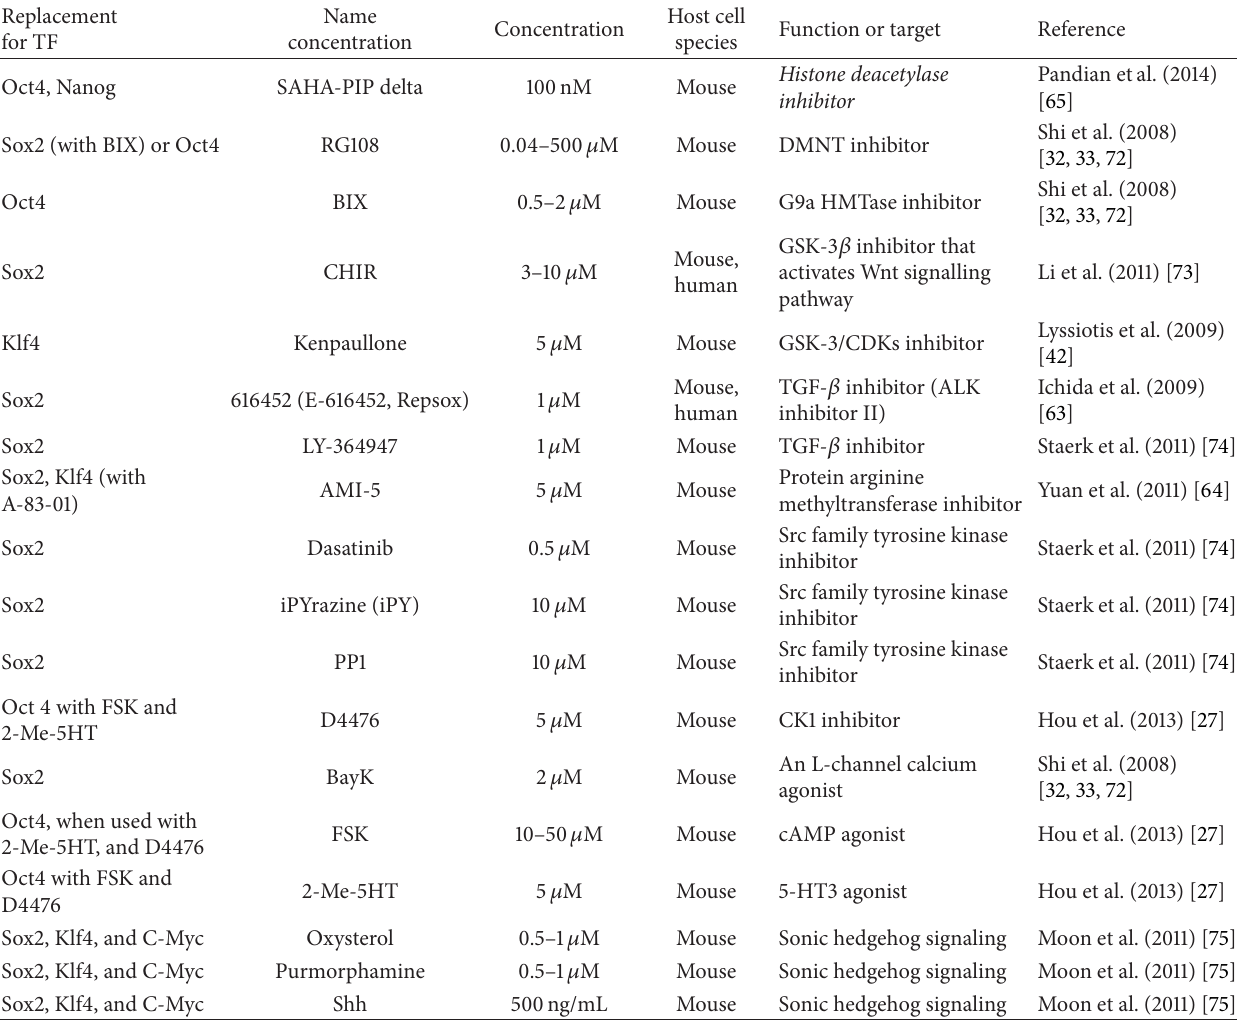
Table 2: Small molecule compounds that might replace Yamanaka